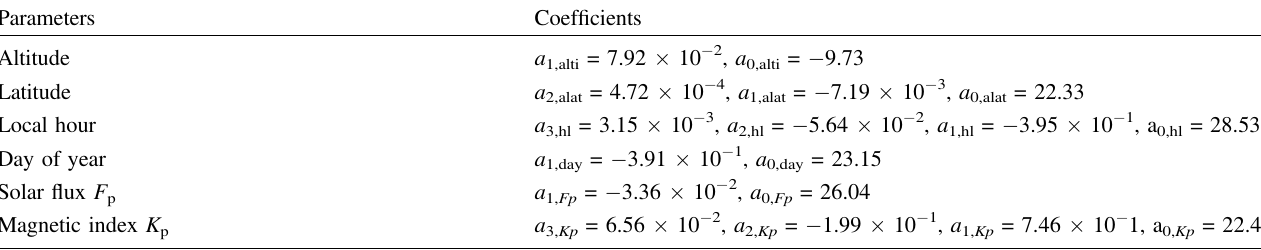
Table 1. List of polynomial coef fi cient values for each parameter. Parameters Coef fi cients Altitude